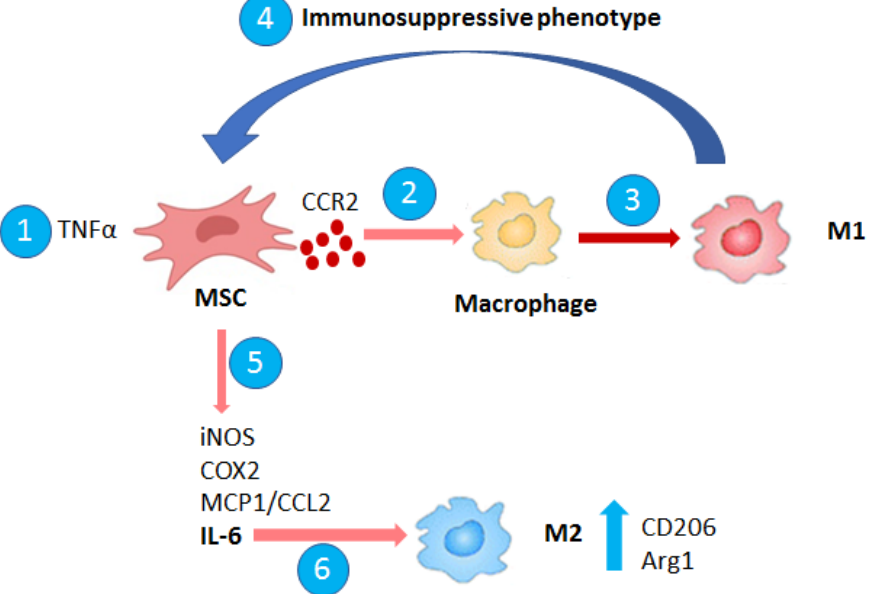
Figure 1. Macrophage–MSC interaction. MSCs activated by TNFα recruit macrophages via CCR2 secretion. M1 macrophages induce MSC immunosuppressive phenotype and enhance iNOS, COX2, MCP1/CCL2, and IL-6 levels. In particular, IL-6 secretion by MSCs induces M2 phenotype with increase of CD206 and ARG1 levels.